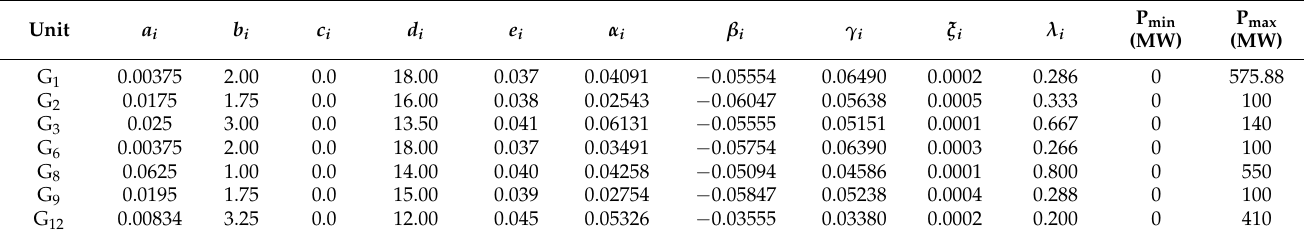
Table A6. System data of units with single-fuel coefficients considering valve-point effect and emission coefficients.